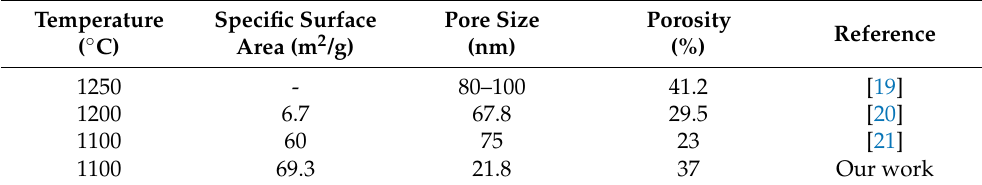
Table 2. Textural properties of reported